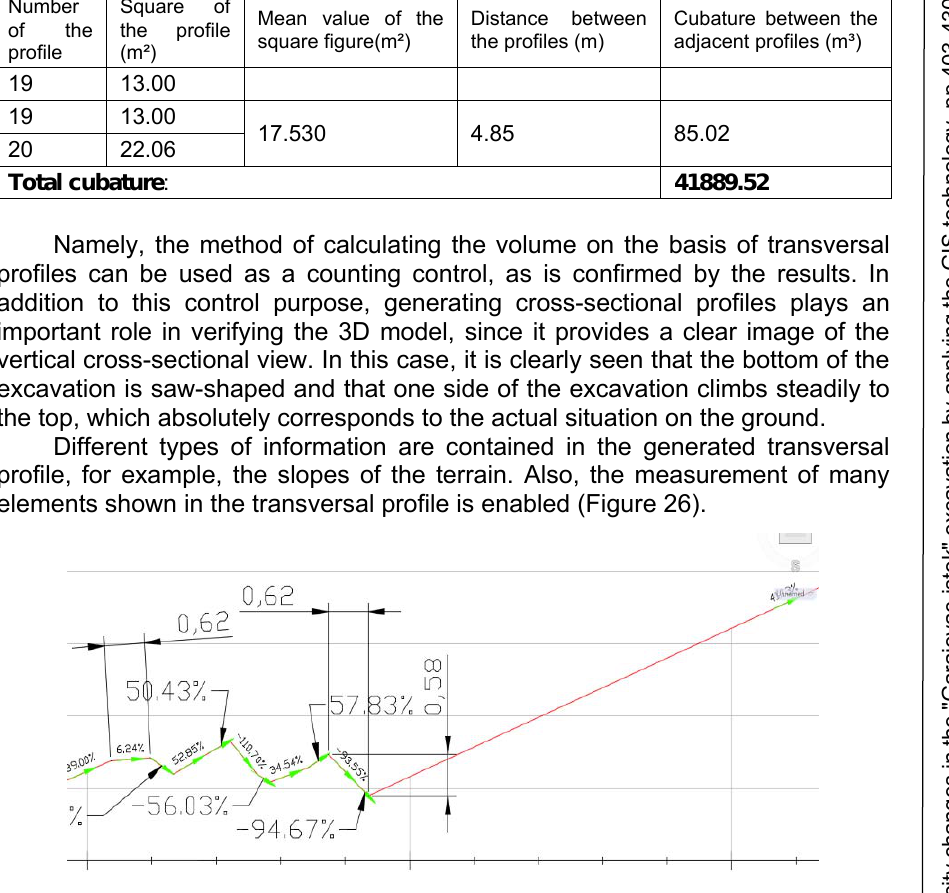
Figure 26 – Slopes of the surfaces shown on the transversal profile of the 3D surface model